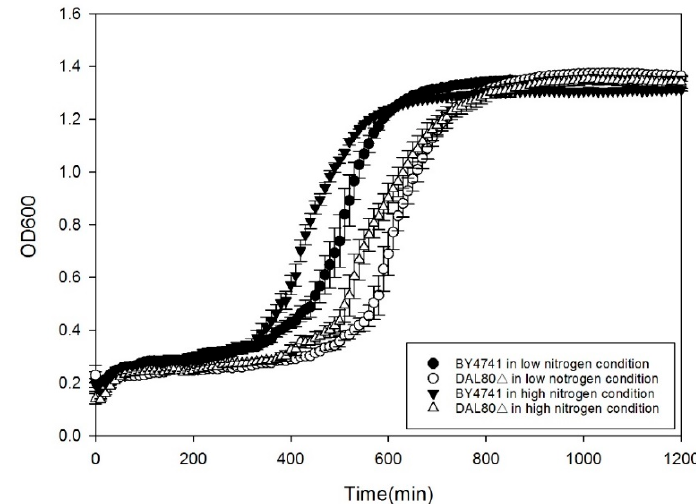
Figure 1. Growth curves of BY4741 and dal80 Δ strains under poor nitrogen condition and rich nitrogen condition.